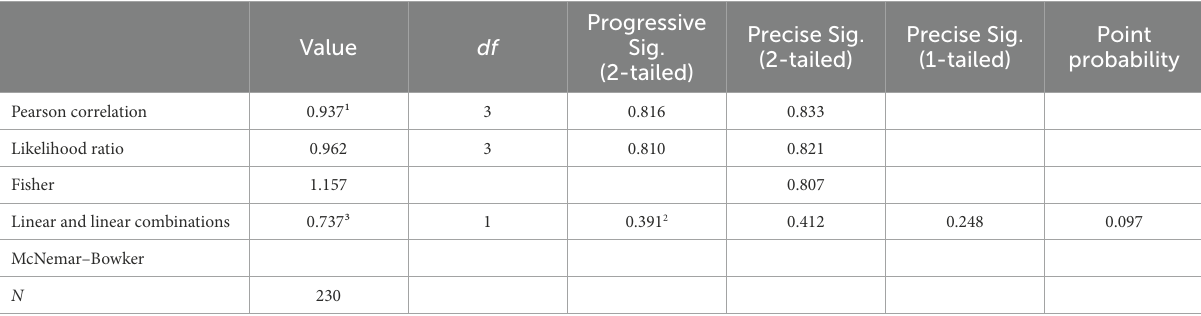
TABLE 3 Pearson correlation; Sarol and gender.